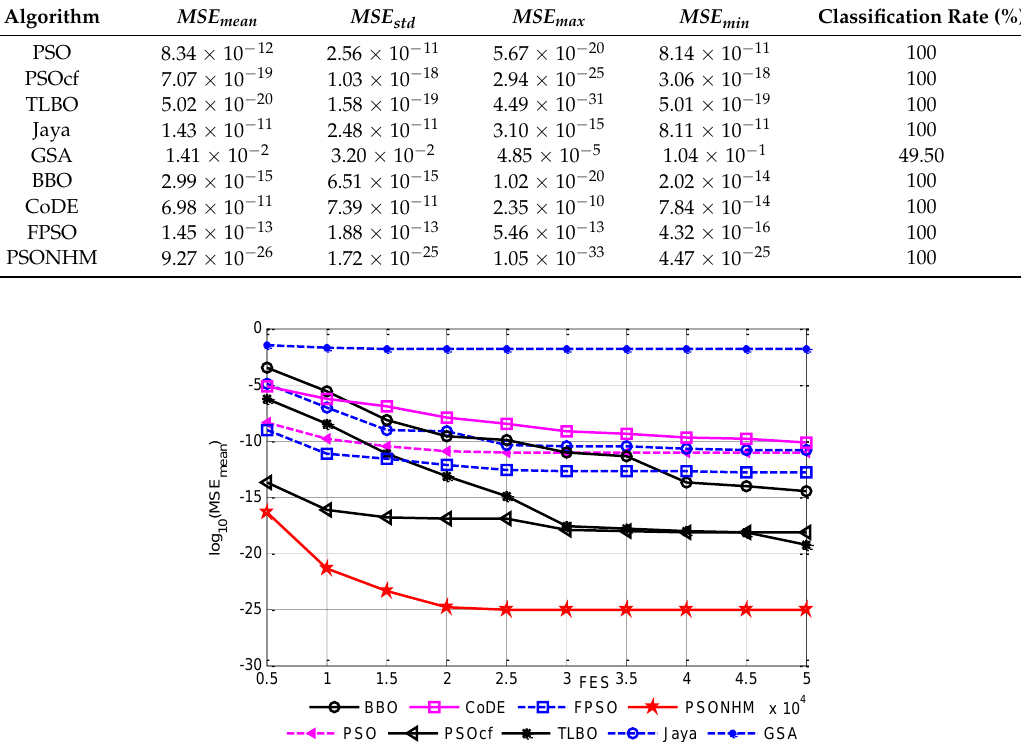
Table 7. Experimental results for the Iris dataset.